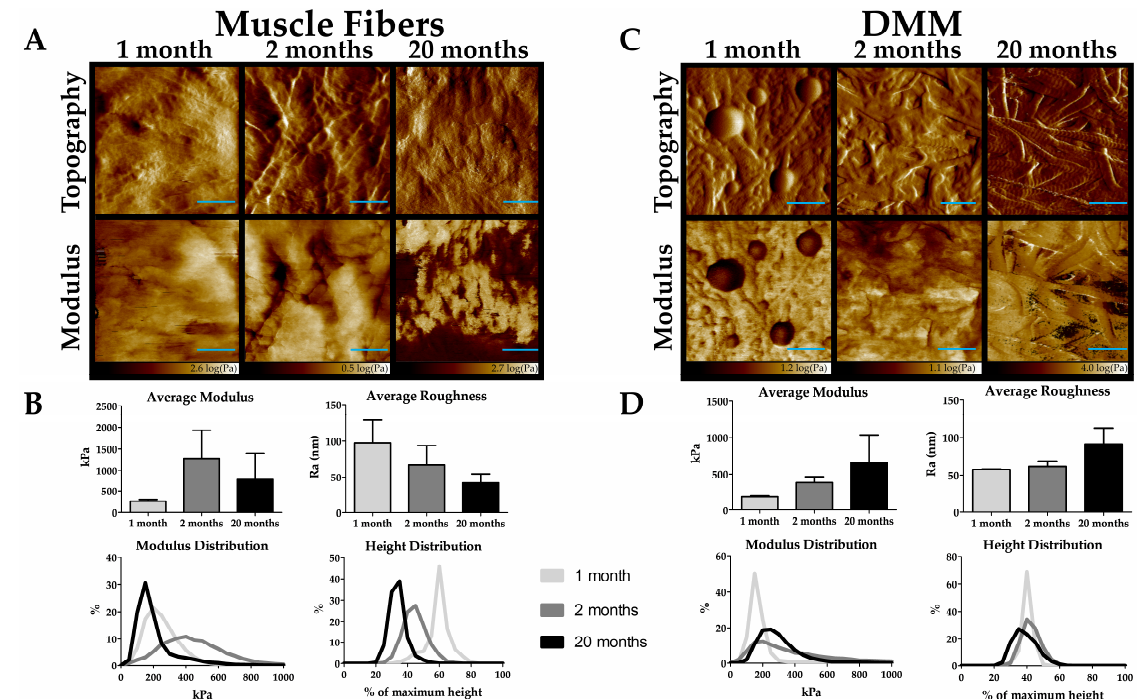
Figure 6. Atomic Force Microscopy imaging shows an increase in stiffness with age in decellularized muscle matrix (DMM). ( A ) The topography and modulus maps of muscle fibers show no noticeable difference with age. ( B ) The modulus of immature muscle fibers is reduced compared to 2 and 20 months. The average roughness of muscle fibers decreased with age, and the peak of the height distribution decreases with age. ( C ) The topography of DMM shows an increase in collagen structure with age. The topography of modulus is increased in old age. ( D ) The average modulus increased with age in DMM, and the peak of the modulus distribution is shifted to a higher value in old age. The average roughness is increased in old age compared to immature and young adult DMM. The peak of the height distribution is shifted slightly lower in old age. (n = 3 for all data in this figure). Scale bar = 500 nm.